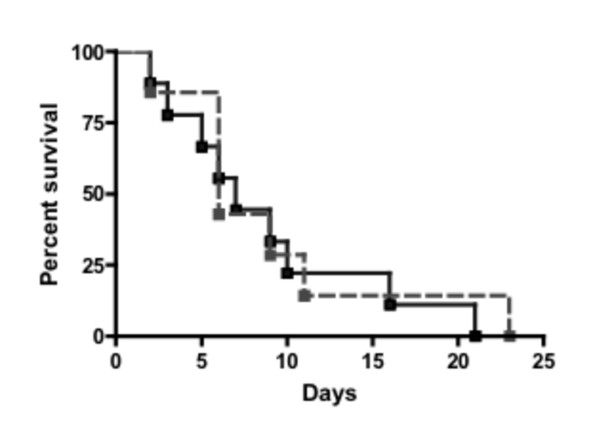
IRAK4-deficient mice maintain defence against Gram negative bacteria. IRAK4 -/- (dotted line) and age- and sex-matched C57BL wild type (solid line) mice were infected with S. typhimurium SL1344 and monitored for survival (y-axis) over time (x-axis). The result is representative of two independent experiments where lack of statistical significance (p = 0.69 and p = 0.13) for differential survival between two groups of eight infected mice was determined by the chi-square test.